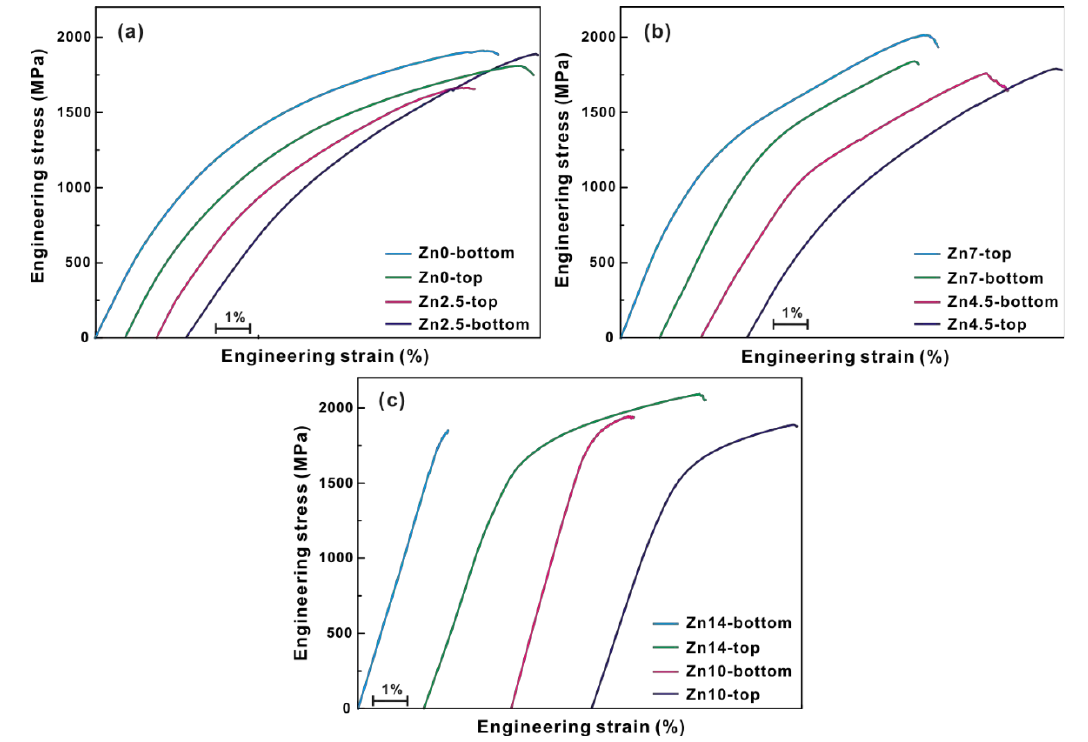
Figure 4. Compressive strain-stress curves of the as-cast (Cu 0.5 Zr 0.5 ) 100− x Zn x rods with a diameter of 2 mm: ( a ) x = 0 and 2.5 at. %, ( b ) x = 4.5 and 7 at. %, and ( c ) x = 10 and 14 at. %; Compressive curves of the top and bottom parts of the as-cast rods were blue and green curves, respectively. Table 1. Yield strength, fracture strength, and plastic strain of different (Cu 0.5 Zr 0.5 ) 100− x Zn x ( x = 0, 2.5, 4.5, 7, 10, and 14 at. %) BMGs and composites.